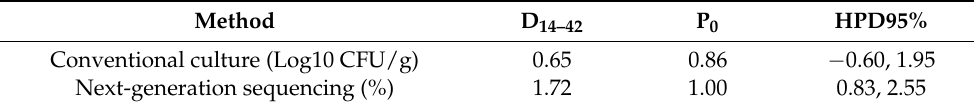
Table 2. Bayesian analyses of the Campylobacter load in caecal samples by the conventional cultured method according ISO 10272:2018 and next-generation sequencing method by MinION nanopore technology. Caecal samples were compared at 14 and 42 days of the rearing cycle.